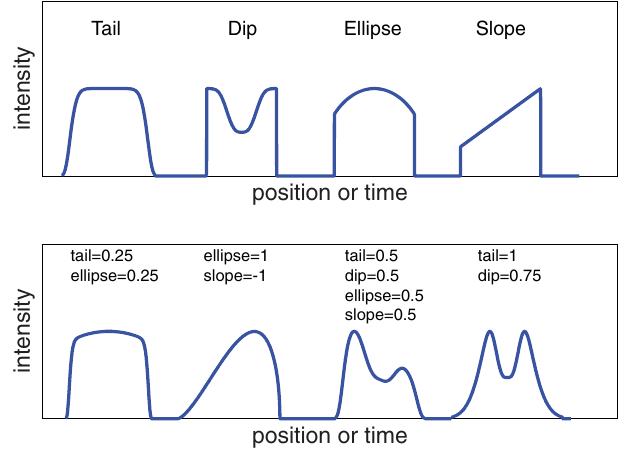
FIG. 6. Above: Archetypal laser pulse shapes, variably super- imposed to form the requested laser pulse shape. Below: Sample pulse shapes including their superposition